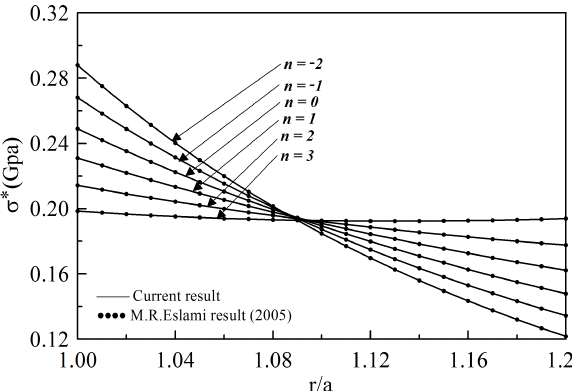
Figure 7: Radially distributed displacement